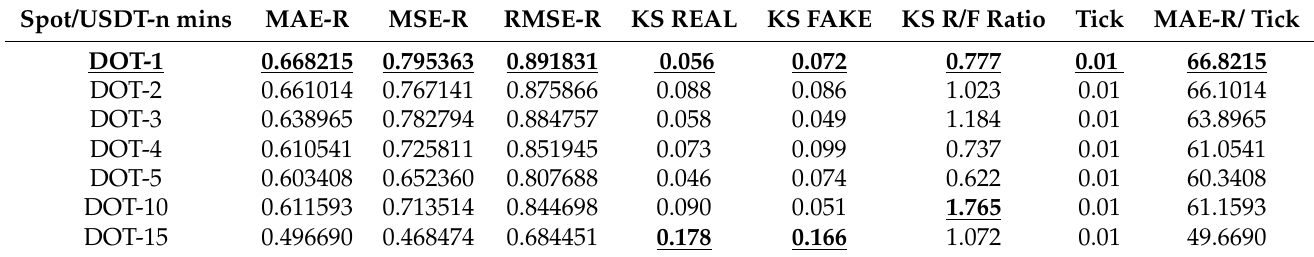
Table 15. We compared DOTUSDT spot prices against generated prices at intervals of one, two, three, four, five, ten, and fifteen minute intervals. DOTUSDT 15 minutes KS are the largest among all time intervals.